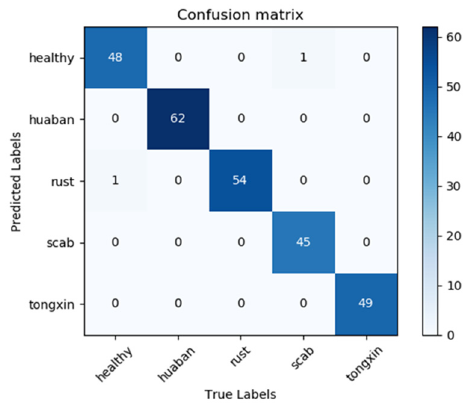
Figure 7. The confusion matrix of the test set.